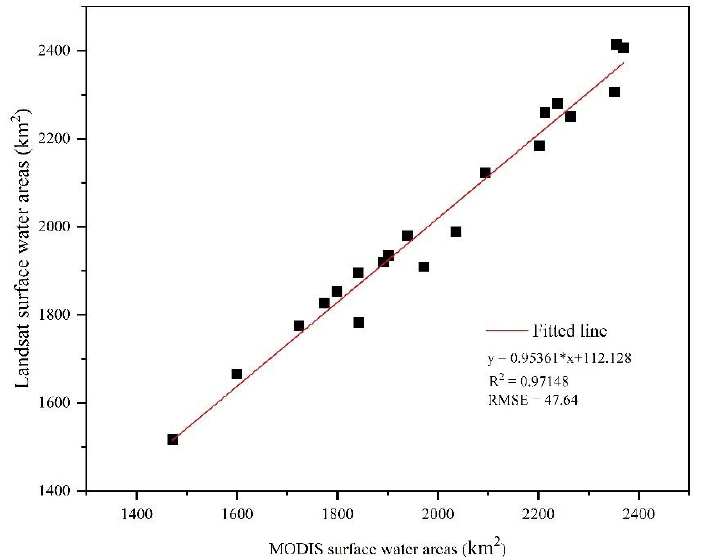
Figure 3. Correlation of annual maximum surface water between Landsat and